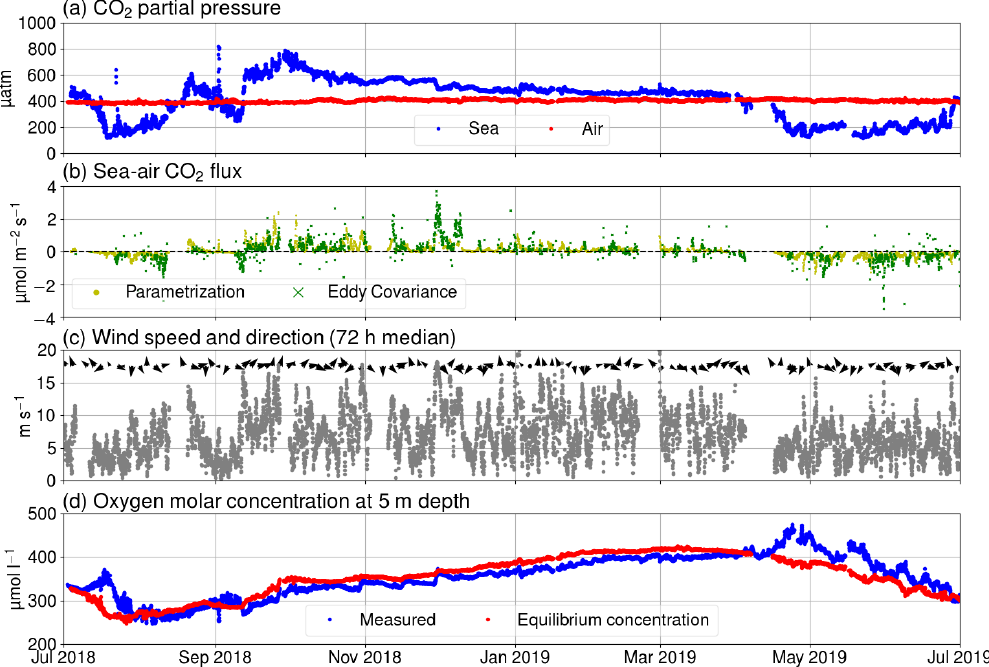
Figure 3. (a) p CO 2 in air (red) and seawater (blue), (b) F as measured using the eddy covariance method (green) and calculated using Eq. (A3) (yellow), (c) wind speed (gray dots) and direction (black arrows), and (d) oxygen molar concentration of seawater as measured (blue) and calculated for hypothetical equilibrium with the atmosphere